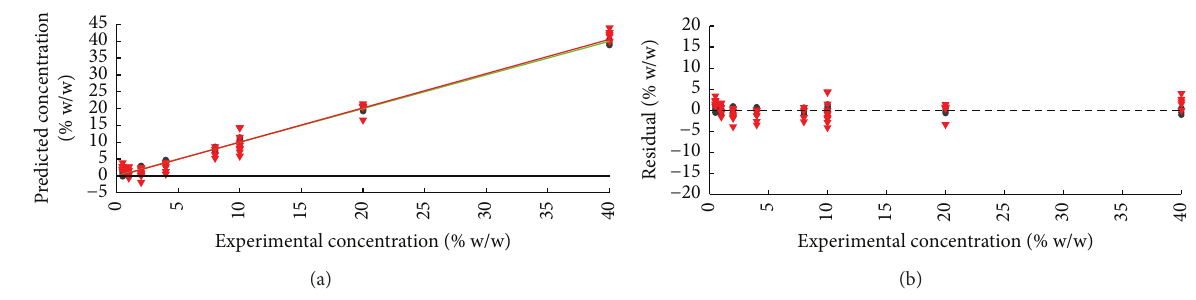
Figure 3: (a) Experimental versus predicted values of adulteration (% w/w) of coffee samples based on the optimized PLS model after outlier removal. (b) Residual versus adulteration levels (% w/w) of coffee samples based on the optimized PLS model after outlier removal.